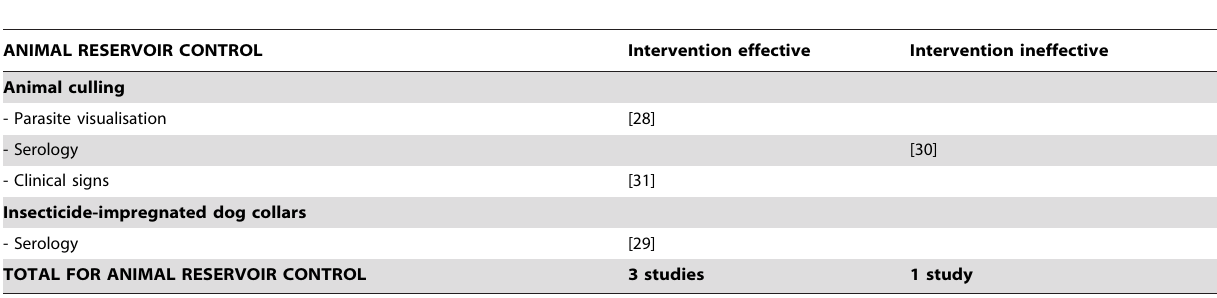
Table 1. Summary table of human outcome measurements for animal reservoir control interventions (with references in brackets).